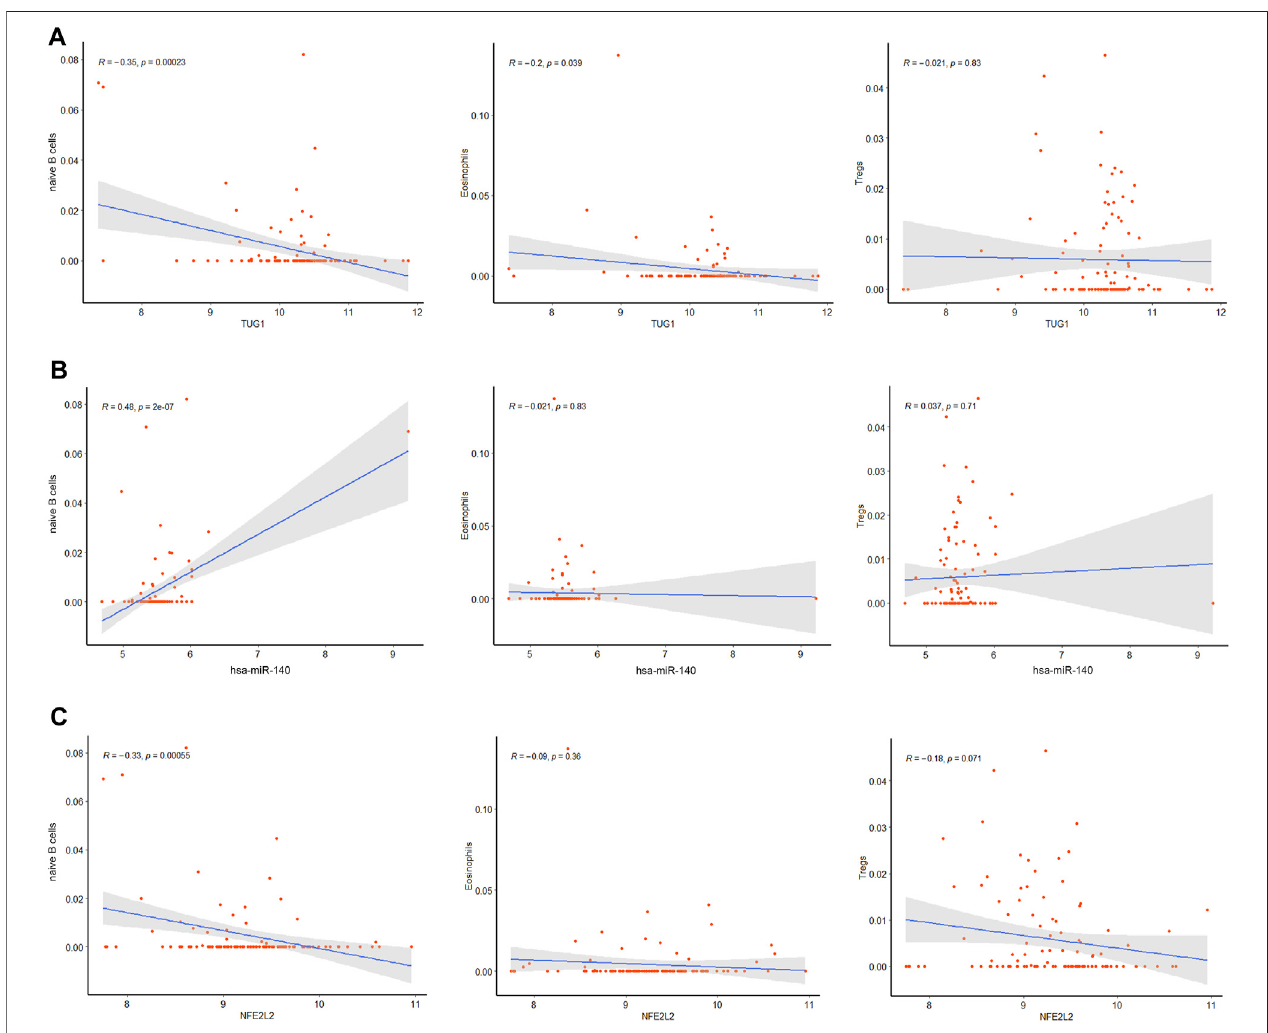
FIGURE9| Co-expressionpatternsofthedifferentiallyexpressedimmunecellsandcoreDEmRNAs. (A) ThecorrelationbetweenTUG1anddifferentiallyexpressed immune cells. (B) The correlation between miR-140 and differentially expressed immune cells. (C) The correlation between NFE2L2 and differentially expressed immune